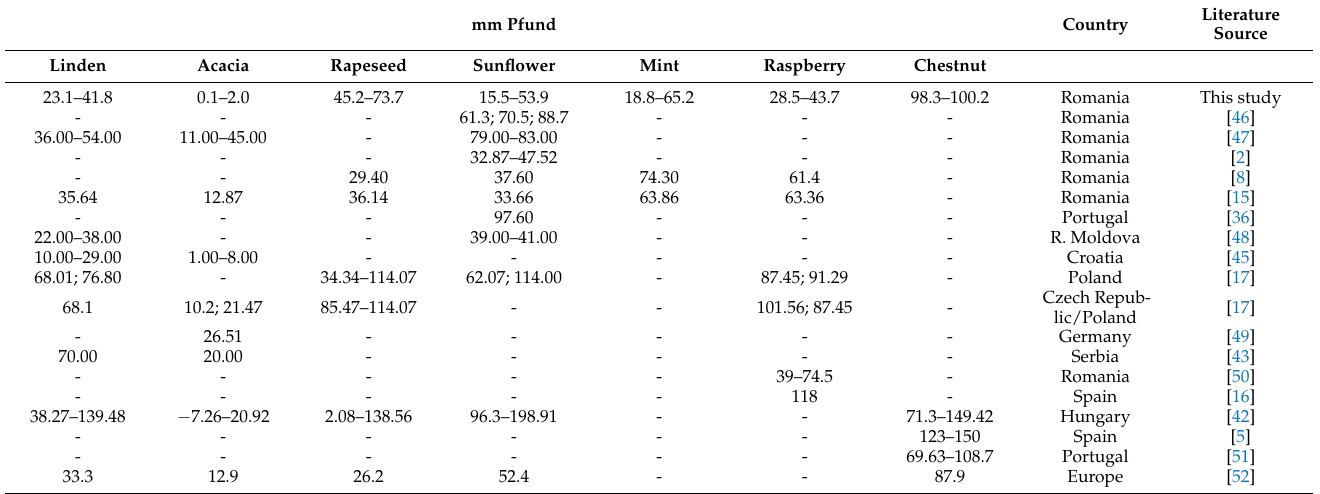
Table 9. Comparative results on color intensity (mm Pfund) of different floral-type honeys.